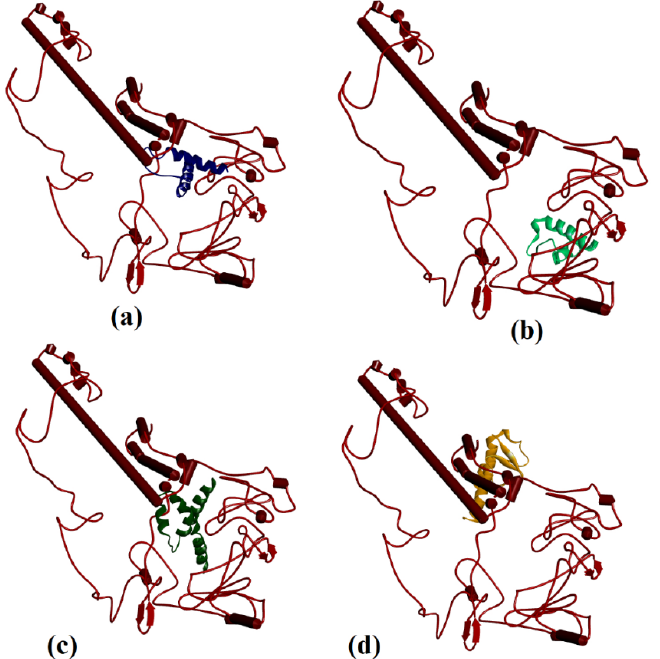
Figure 3. ( a ) Apamin and normal Ebola viral spike protein interaction; ( b ) MCD and normal Ebola viral spike protein interaction; ( c ) melittin and normal Ebola viral spike protein interaction; ( d ) secapin and normal Ebola viral spike protein interaction .